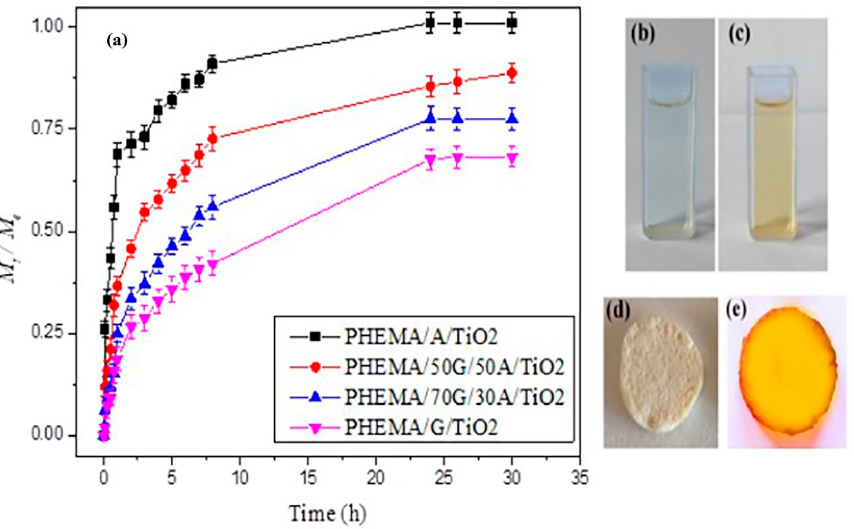
Figure 9. ( a ) Curcumin release profiles from PHEMA/G/A/TiO 2 hybrid scaffolds; release medium after ( b ) 1 h and ( c ) 24 h of curcumin release; photographs of ( d ) unloaded and ( e ) curcumin loaded PHEMA/G/TiO 2